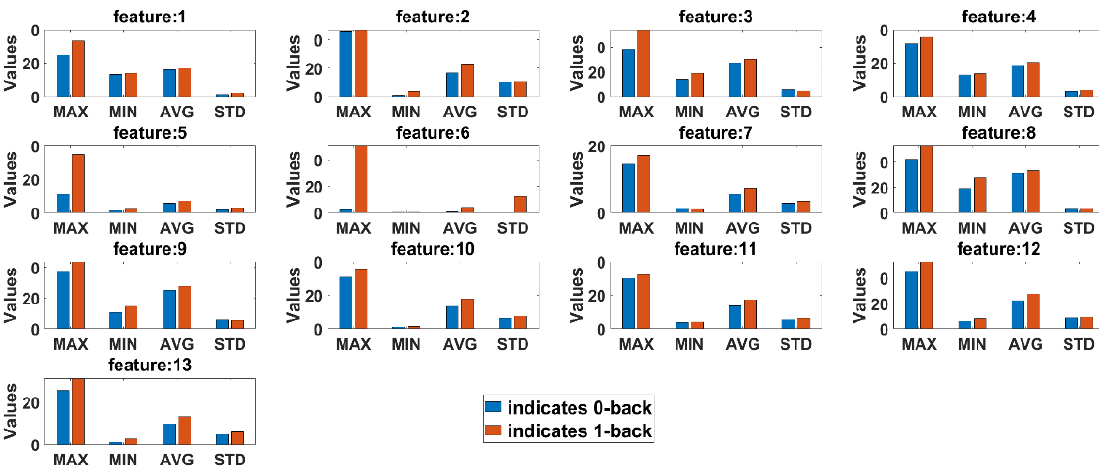
Figure 14. Summary of the statistical parameters comparing n-back task 0 and 1 considering features camera system.